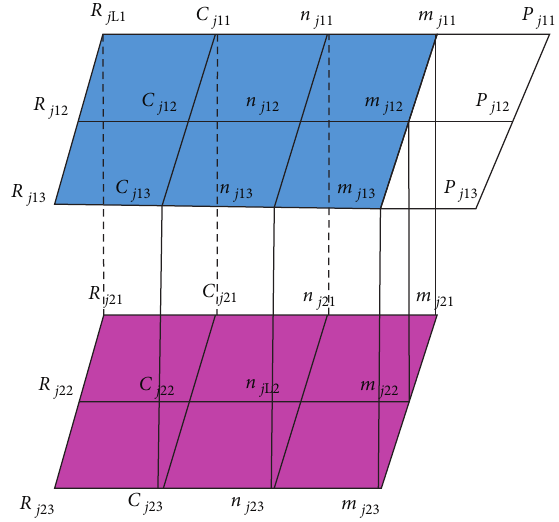
Figure 3: Distribution of variables to be